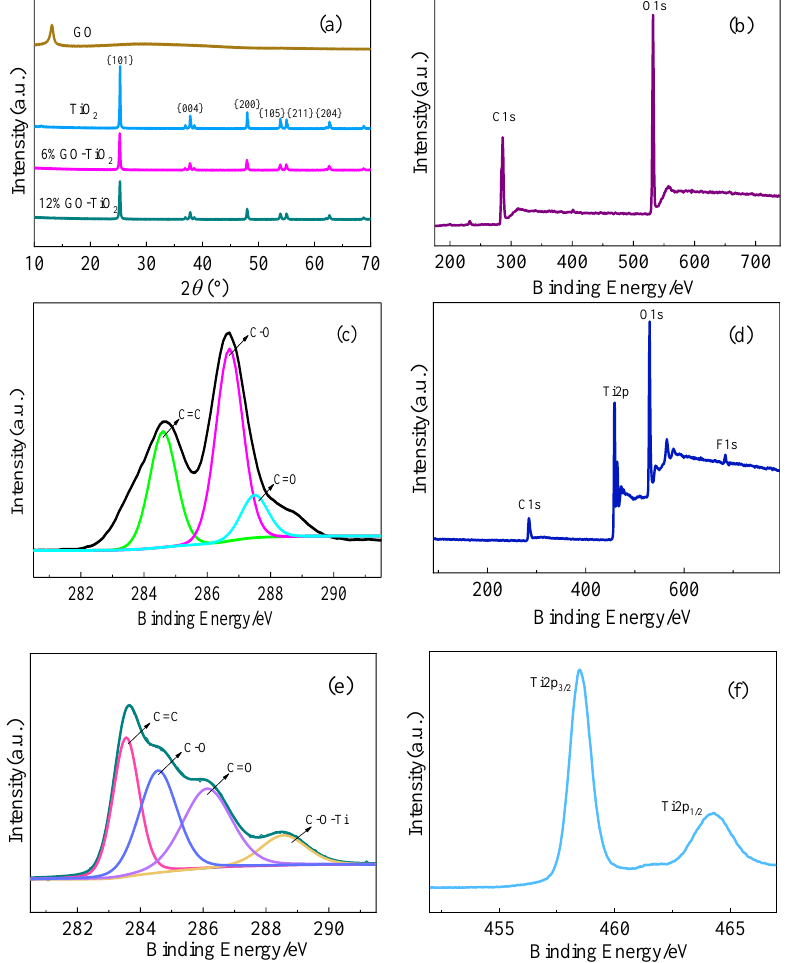
Figure 4. ( a ) XRD spectrum of GO, ( b ) XPS survey spectrum of GO, ( c ) C1s spectrum of GO, ( d ) XPS survey spectrum of TiO 2 -6%RGO, ( e ) C1s spectrum of TiO 2 -6%RGO, ( f ) Ti2p spectrum of TiO 2 -6%RGO.